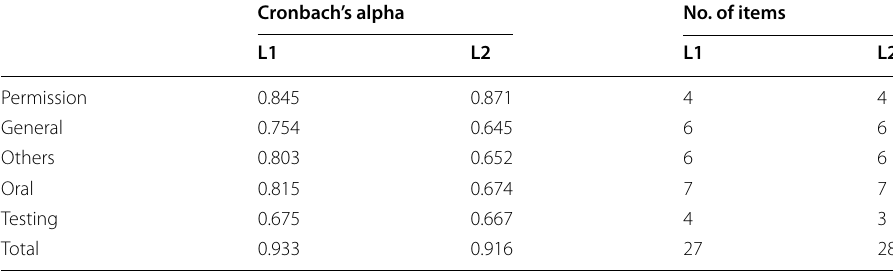
Table 4 Reliability statistics of L1 and L2 questionnaires and their